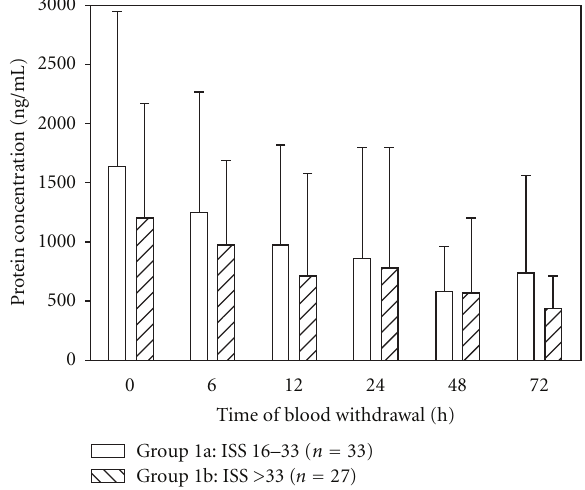
Figure 4: There is a lower serum MMP-9 activity in patients presenting with an ISS > 33 points in contrast to those with an ISS ≤ 33 regarding the first 12h after trauma. Concerning the other points of time, there is no further remarkable significant di ff erence between group 1a and 1b. Data were analyzed by Mann-Whitney Rank Sum test and presented by mean ± standard error of the